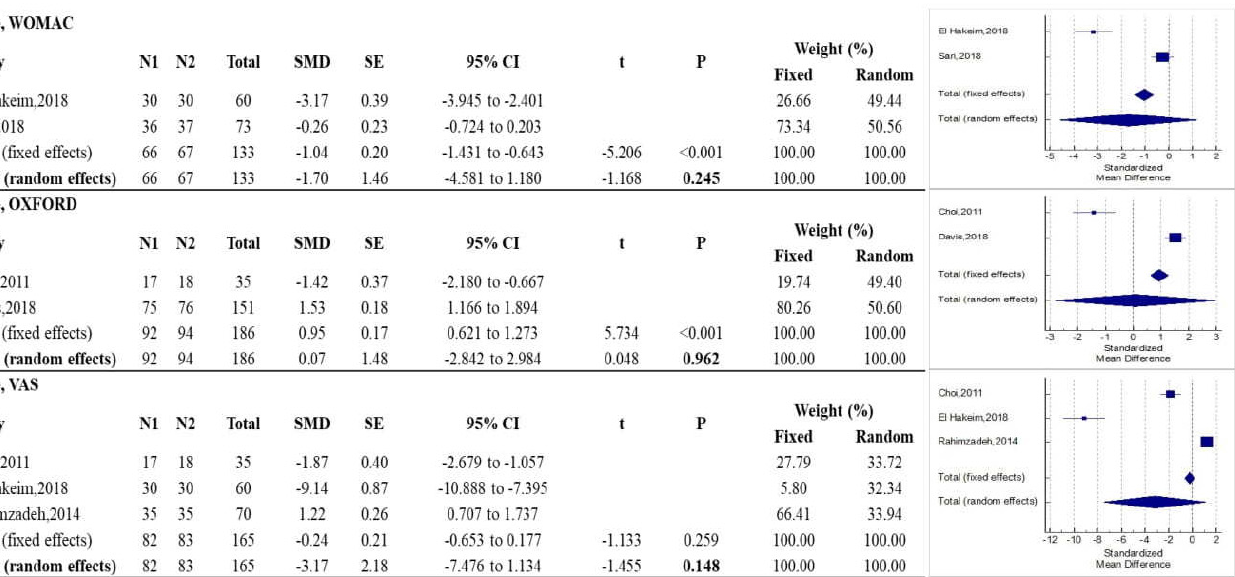
Figure 5. Forest plots showing intervention effects on the knee: WOMAC, OXFORD, and VAS outcomes. The use of fixed or random effects (bold) is chosen based on the results of the Higgins’ heterogeneity test. Note: N1 = no. of patients in the intervention group; N2 = no. of patients in the control group; SMD = standardized mean difference; CI = confidence